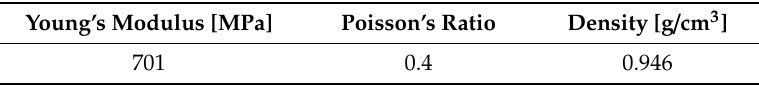
Table 5. Mechanical properties of